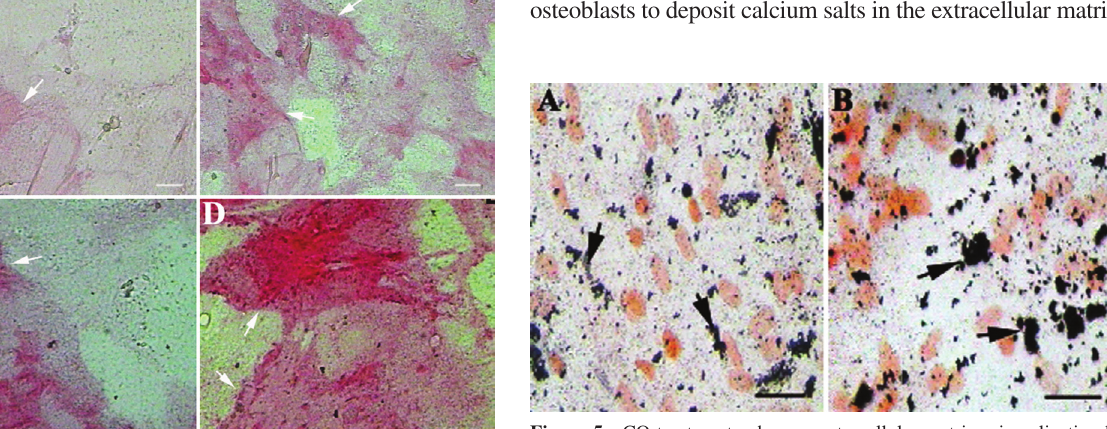
Figure 5 - CQ treatment enhances extracellular matrix mineralization by differentiating MSCs grown in osteogenic media: MSCs grown in osteo- genic media show mineralization of the extracellular matrix after 28 days (A). Interestingly, more intense mineralization was observed by the 7 th day when MSCs grown in osteogenic media were treated with 300 µg/mL CQ extract (B), suggesting strong induction of matrix calcification by the CQ extract. Scale bar=50